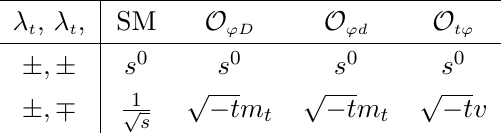
t v ) for th th scattering. (cid:24) (cid:0) (cid:29) ! ’ indicate any combination of ; . See (cid:3) (cid:6) (cid:7)